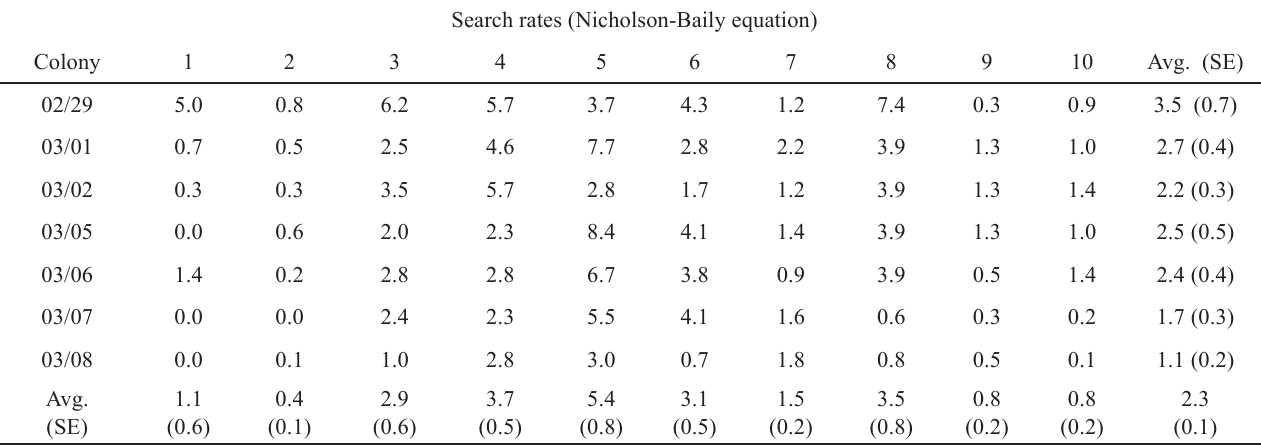
Table 4 . The estimated search rates (×10 -5 ) per observation period (45 min) for each colony on each day using the Nicholson-Baily functional response